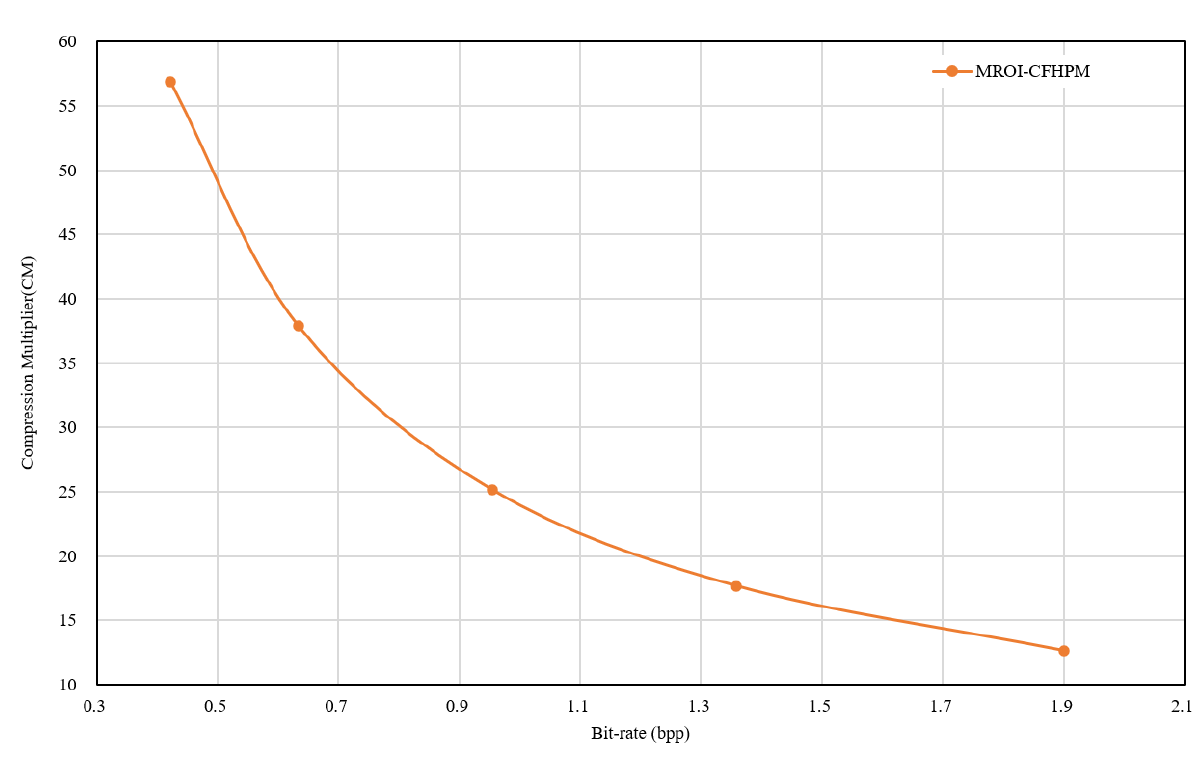
Figure 11. Changes in compression factor at a different